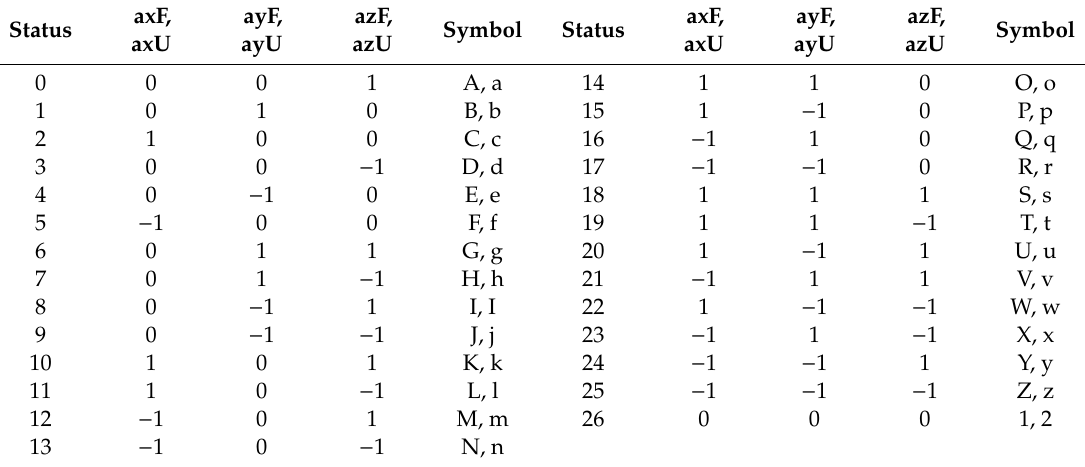
Table 1. Action sequence conversion process based on the labeling